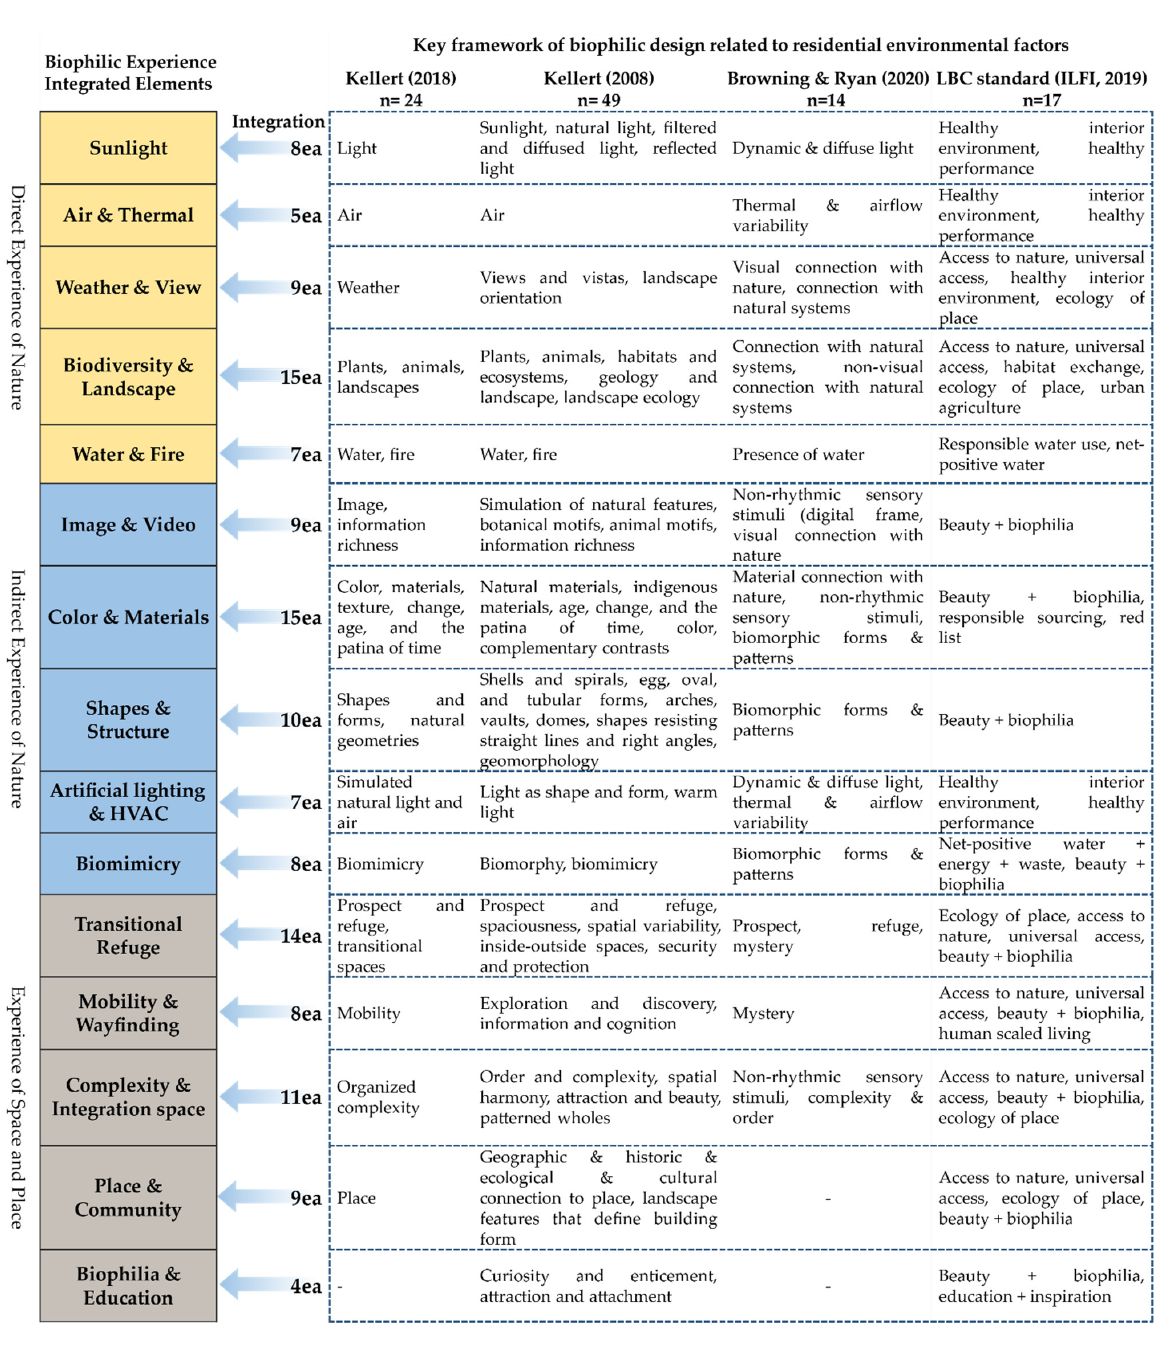
Figure 5. Biophilic experience-based integrated framework and process [6,62,81,83].